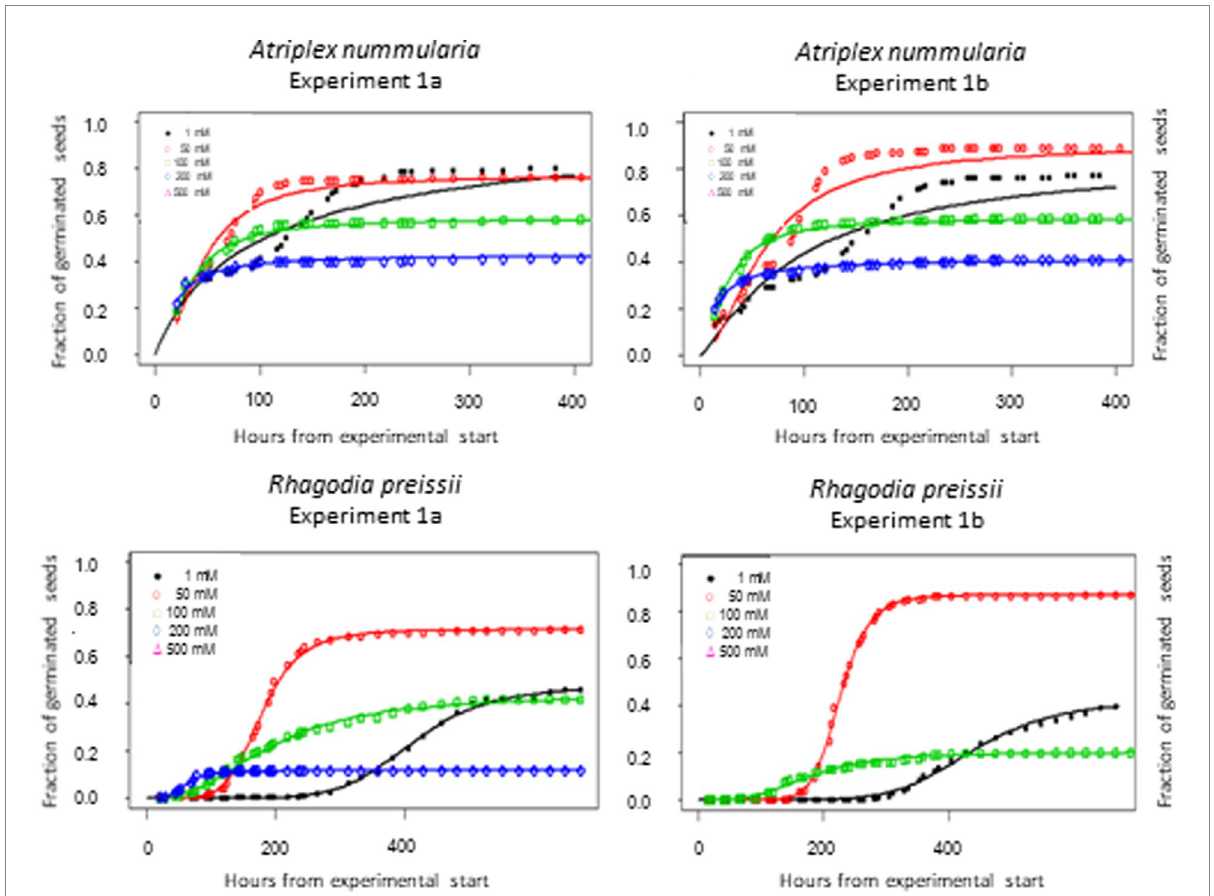
FIGURE 3 Germination curves for A. nummularia and R. preissii at four constant temperatures. In experiment 1B at 30 ° C no seeds of R. preissii